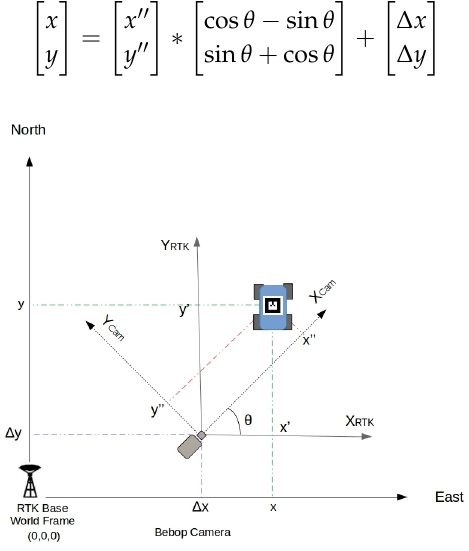
Figure 4. Reference corrections in the x–y